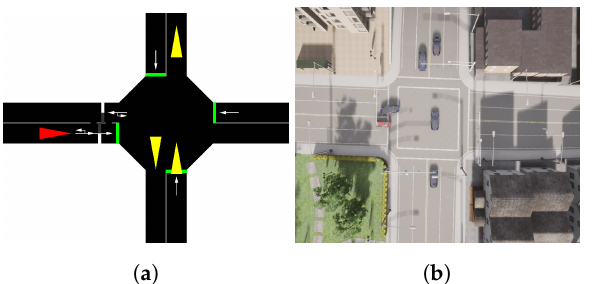
Figure 7. CARLA and SUMO intersection scenarios. ( a ) Bird-eye-view of the intersection in SUMO Simulator. ( b ) Bird-eye-view of the intersection in CARLA